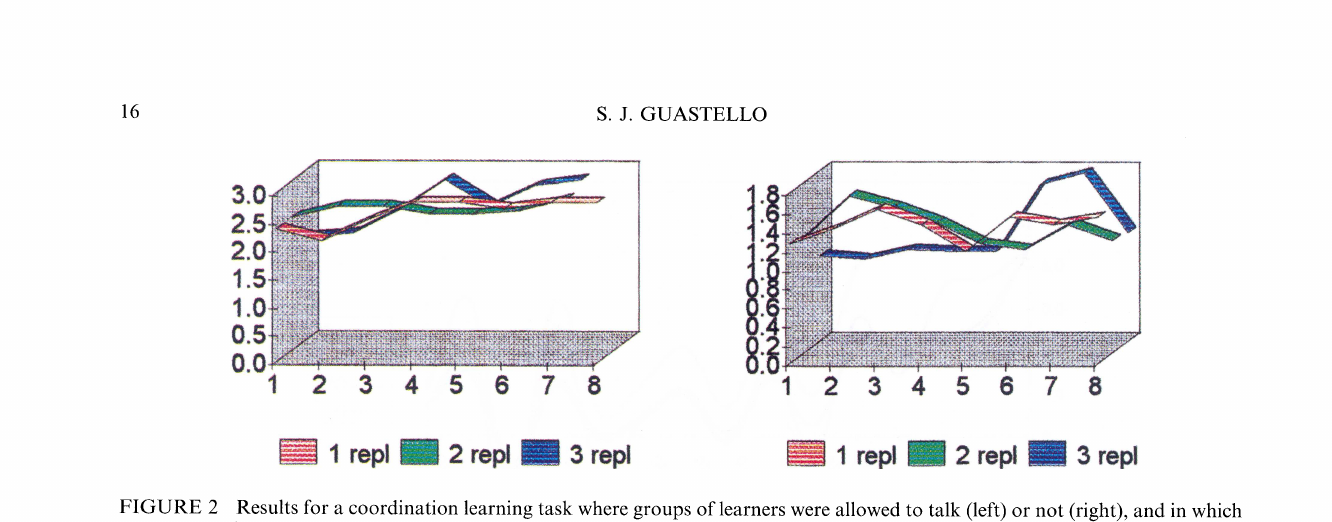
FIGURE 2 Results for a coordination learning task where groups of learners were allowed to talk (left) or not (right), and in which one, two, or three members of the learning group (repl) were replaced during the course of the experiment (from Guastello, Bock and Caldwell, 1999). (See Color Plate I.)